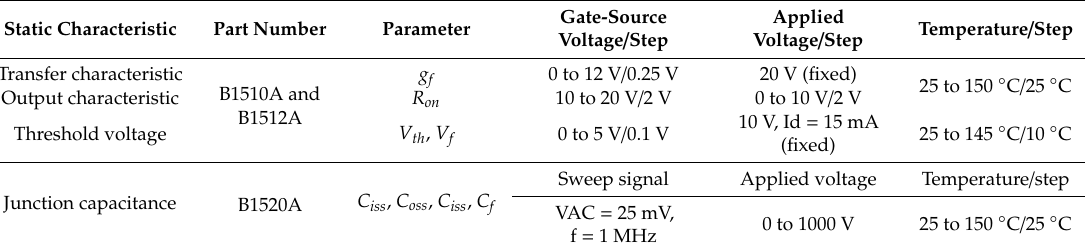
Table 1. Preliminary setting of the state characteristic testing.